Question: Which visualization type does this figure use?
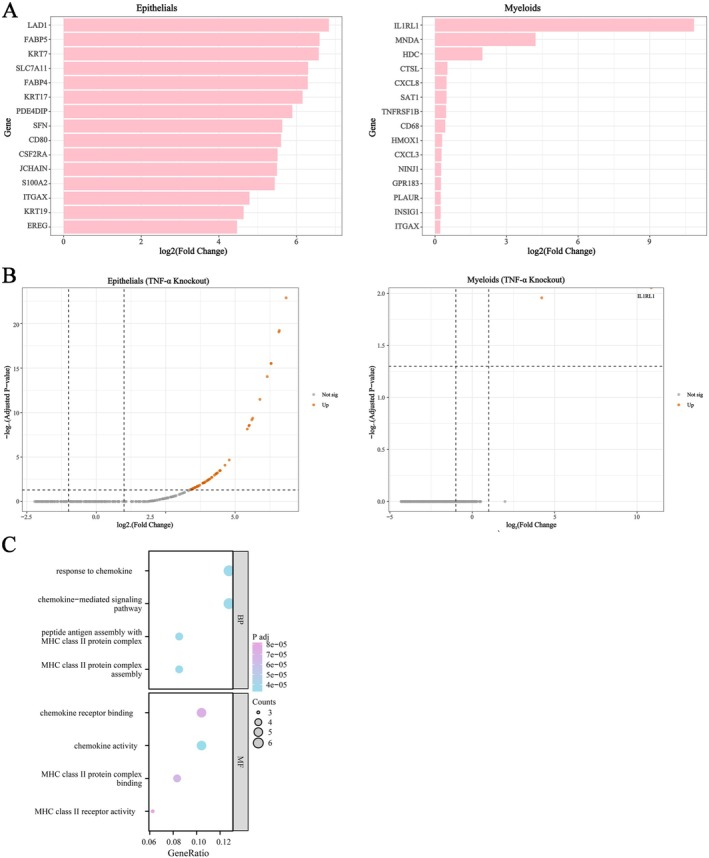
Answer: heatmap